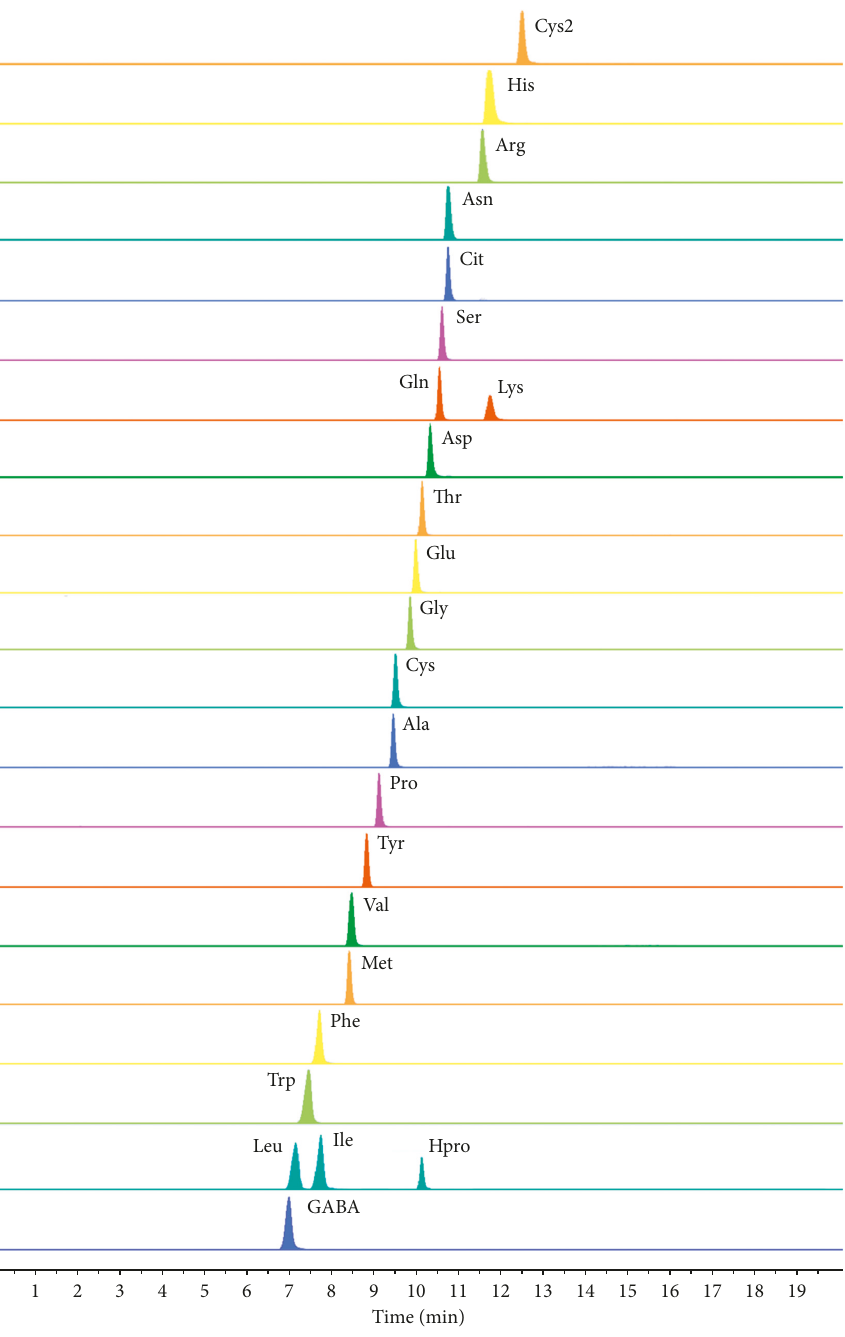
Figure 1: Typical MRM chromatograms of the 24 amino